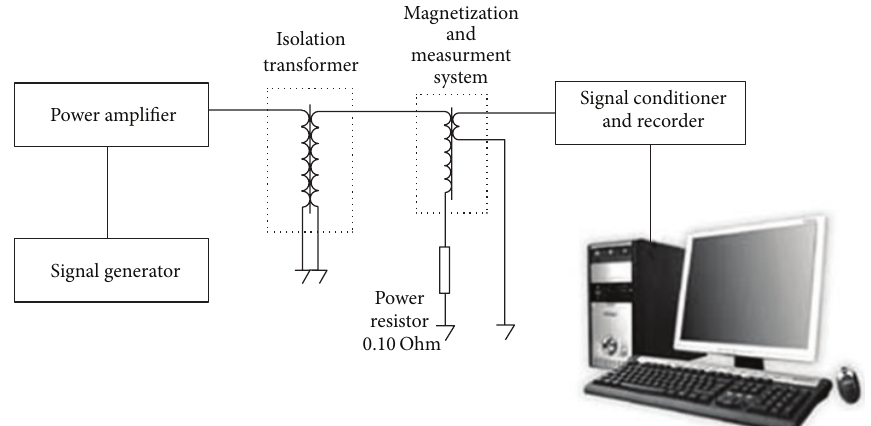
Figure 3: Block diagram of the magnetization system.